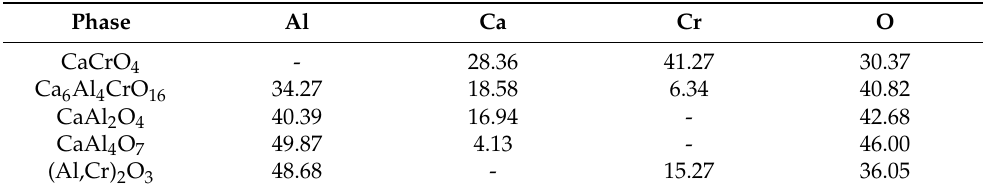
Table 6. Examples of qualitative EDS spot analysis of the samples (atomic%) for identifying various phases in Figure